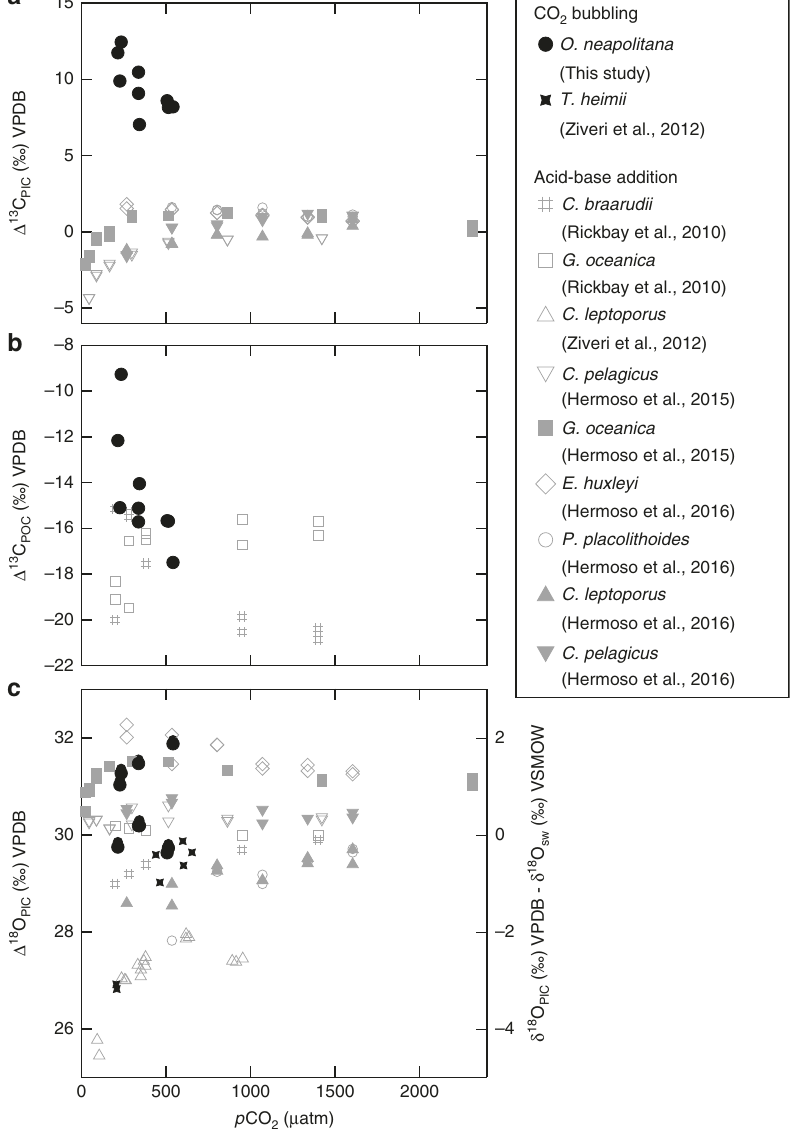
Fig. 4 Stable carbon and oxygen isotopes of O. neapolitana compared to other coccolithophore species. Atmospheric p CO 2 vs. Δ 13 C PIC ( a ), Δ 13 C POC ( b ), and Δ 18 O PIC ( c ) for O. neapolitana (black solid circles) and other coccolithophore species. Δ 18 O PIC and most Δ 13 C POC data for O. neapolitana fall within the range reported for other species, with Δ 13 C PIC being markedly higher. Offsets may be attributable to differences in species and/or method of acidi fi cation, as most past studies manipulate seawater pH via acid – base addition (labeled in gray), while the present study varied seawater pH via CO 2 gas manipulation. Both the trends and absolute values of stable carbon and oxygen isotopes of O. neapolitana are compatible with the framework recently proposed by McClelland et al. 52 , as expanded on in Fig. 5 and the main